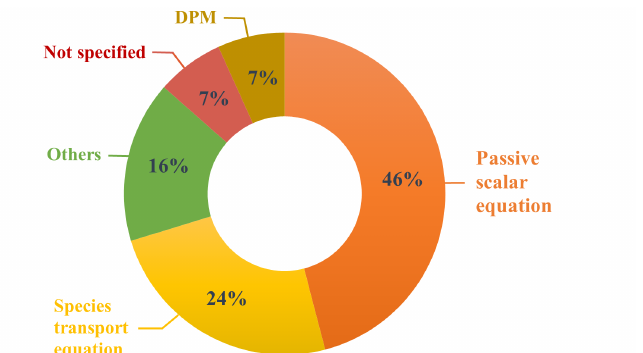
Figure 14. Types of governing equations for pollutant transport used in the investigated